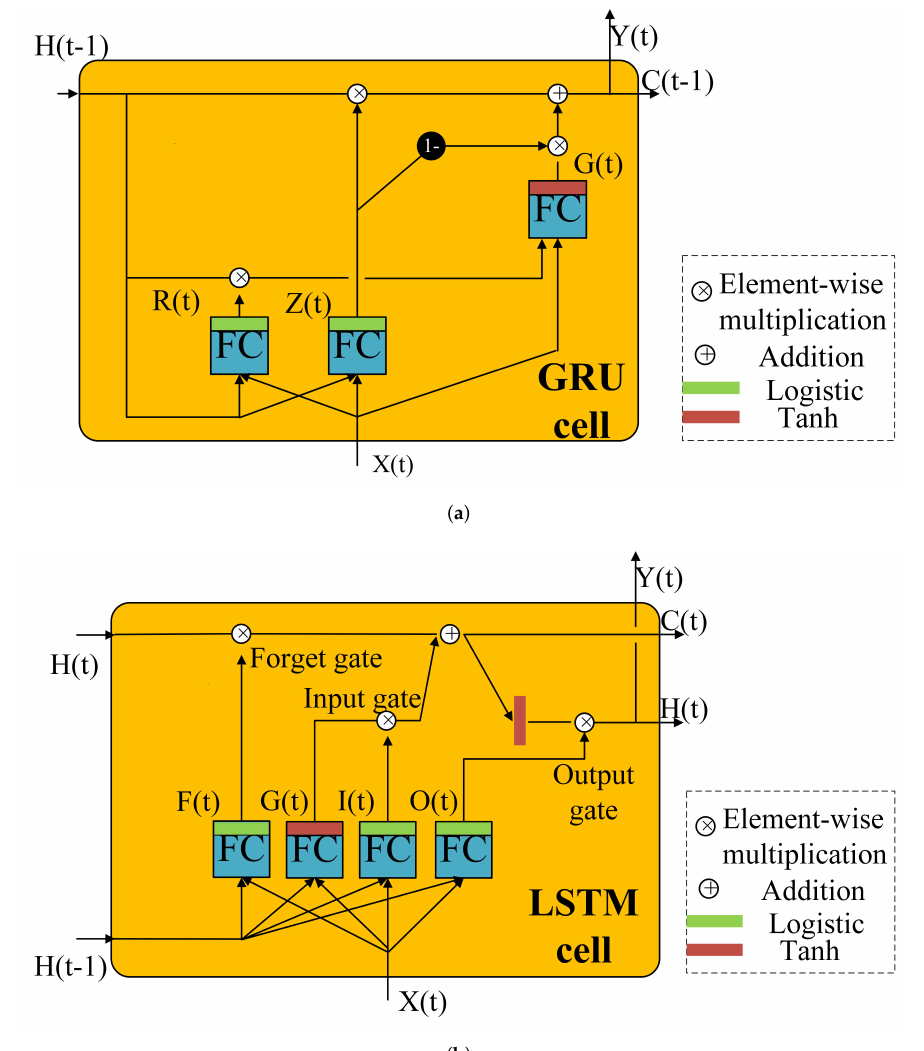
Figure 7. The structures of GRU and LSTM. ( a ) The structures of GRU; ( b ) The structures of LSTM. In GRU, the reset gate helps to capture the short-term dependencies in the time series, and the update gate helps to capture the long-term dependencies in the time series. In theory, GRU can store and retrieve information in long steps. However, GRU has limitations in terms of structure. GRU only uses historical information in the process of feature extraction but does not make use of future information. To overcome this limitation, we use Bi-GRU to build a neural network. The basic structure of Bi-GRU is shown in Figure 8. In this structure, the final output of Bi-GRU at time t depends not only on the previous frame T − 1 at time t but also on the next frame T + 1 at time t. In other words, the Bi-GRU stacked by two GRUs can benefit from the information in the two-time directions. Specifically, one GRU flows forward to calculate the forward hidden state, (cid:126) h (cid:126) h (cid:126) h ( (cid:126) h ) at the same time, another GRU flows backward and calculates the reverse n 2 , 3 . . . 1 , ← ← ← ← h 1 , h 2 , h 3 . . . h n ) . Therefore, at each time step, Bi-GRU can simultaneously hidden state ( capture historical information and future information